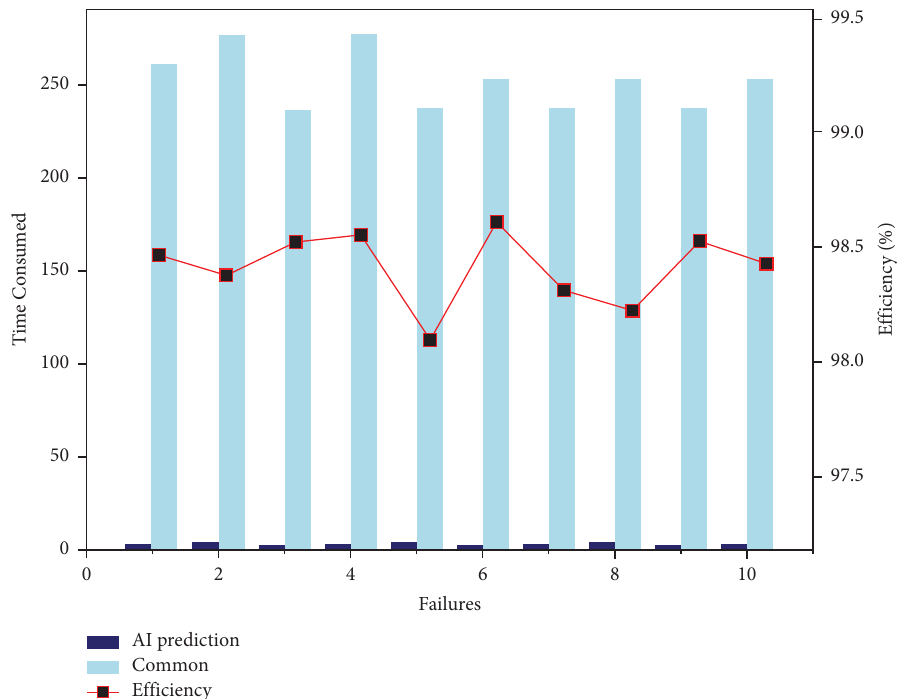
Figure 17: Comparison of time consumption with or without an AI module for detecting the fault